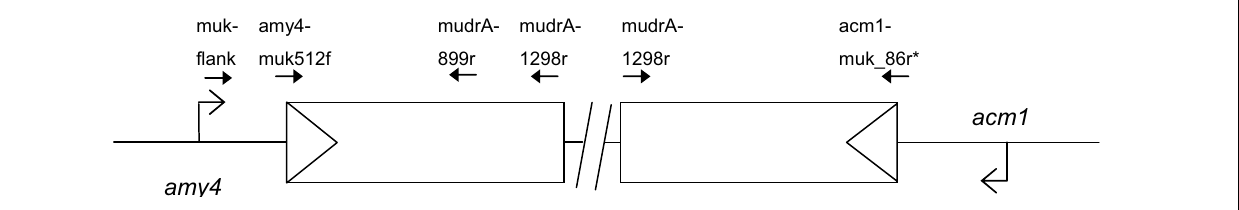
FIGURE 1 | Schematic of the Mu killer locus and the two flanking maize genes amy4 and acm1 . The triangles indicate theTIRA sequences. Primers used in the analysis of Mu killer genomic DNA and RT-PCR products are indicated.